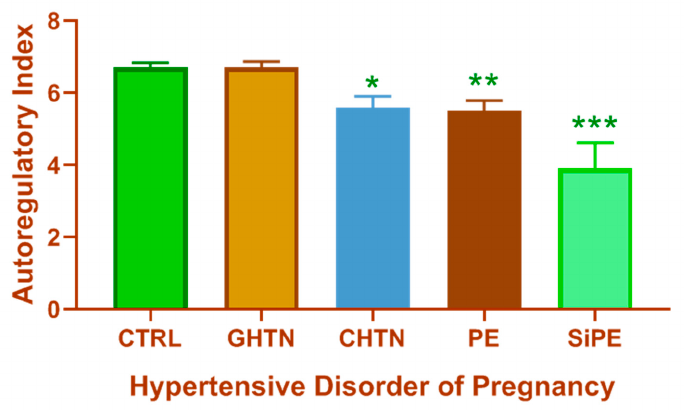
Figure 3. Dynamic CBF autoregulation differs among the different hypertensive disorders of pregnancy. Compared to normal pregnant women (CTRL), pregnant women with chronic hypertension (CHTN), preeclampsia (PE) or superimposed preeclampsia (SiPE) have significantly lower autoregulatory index during pregnancy while women with gestational hypertension (GHTN) have an autoregulatory index similar to that of the CTRL. Women with superimposed preeclampsia have the lowest autoregulatory index of all hypertensive disorders of pregnancy. * p < 0.05, ** p < 0.01, *** p < 0.001 compared to